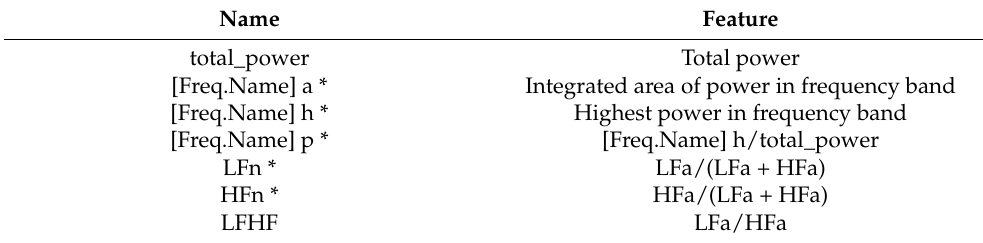
Table 3. Frequency domain features.